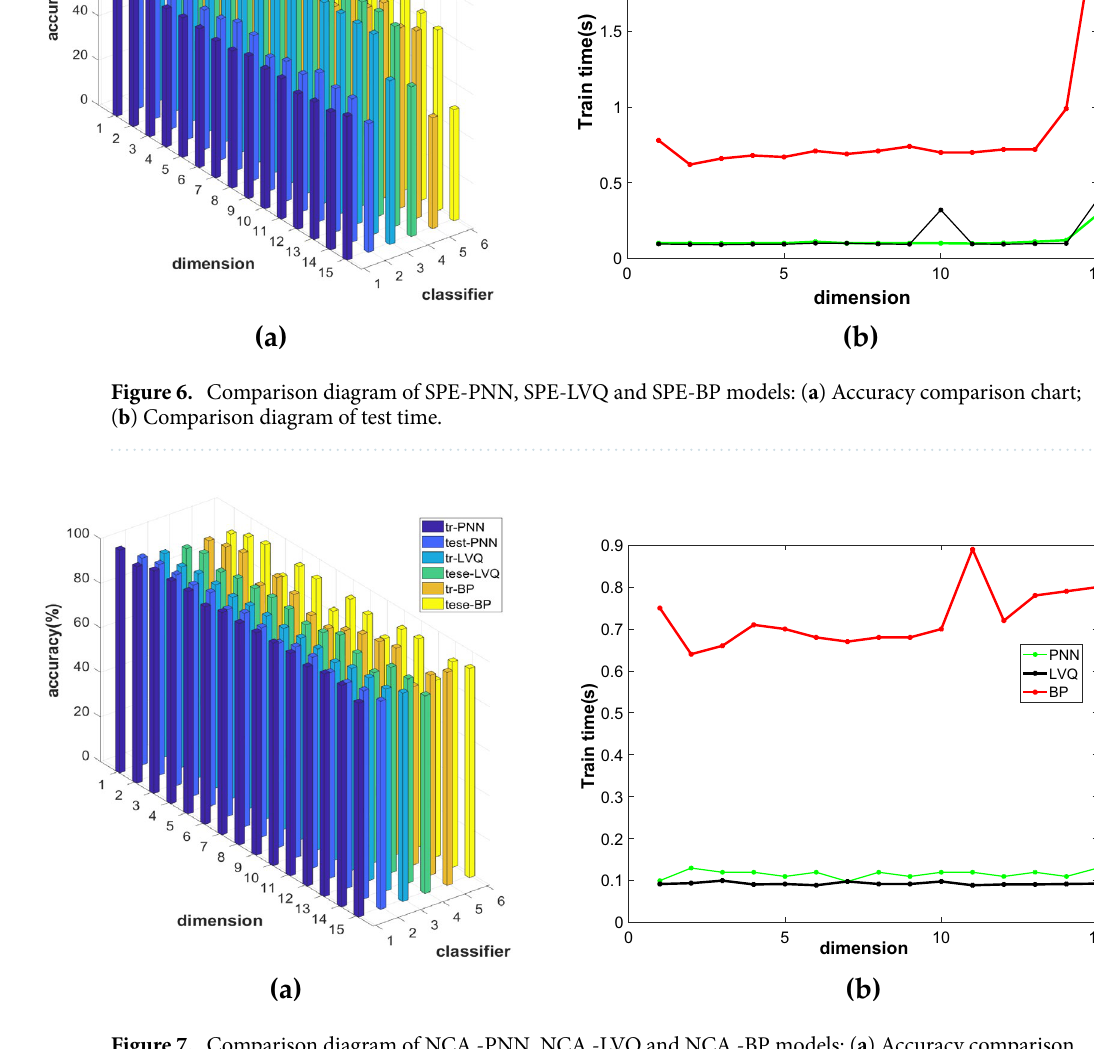
Figure 7. Comparison diagram of NCA -PNN, NCA -LVQ and NCA -BP models: ( a ) Accuracy comparison chart; ( b ) Comparison diagram of test time.